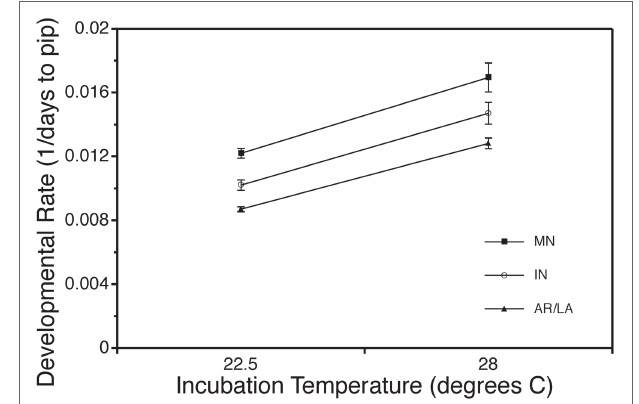
FIGURE 2 | Countergradient variation for developmental rate of embryonic common snapping turtles, Chelydra serpentina . Eggs from Minnesota, Indiana, and Arkansas/Louisiana were incubated at the same temperatures, 22.5 or 28 ° C. Incubation period was recorded as the number of days from oviposition to pipping. Developmental rate is the inverse of incubation period (1/days to pip). Data are modified from Ewert et al.,